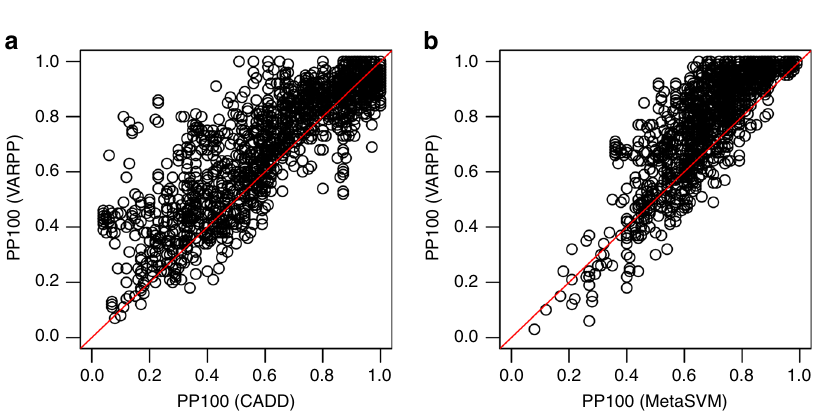
Fig. 2 Performance of VARPP classi fi ers across 1879 HPO Phenotypic Abnormality terms. a Agreement scatter plot comparing the PP100 for VARPP including CADD + GTEx speci fi city ( y axis) versus the PP100 for CADD scores alone ( x axis). b Agreement scatter plot comparing the PP100 for VARPP including MetaSVM + GTEx speci fi city ( y axis) versus the PP100 for MetaSVM scores alone ( x axis). The red line is the line of identity. NATURE COMMUNICATIONS| (2019) 10:5274